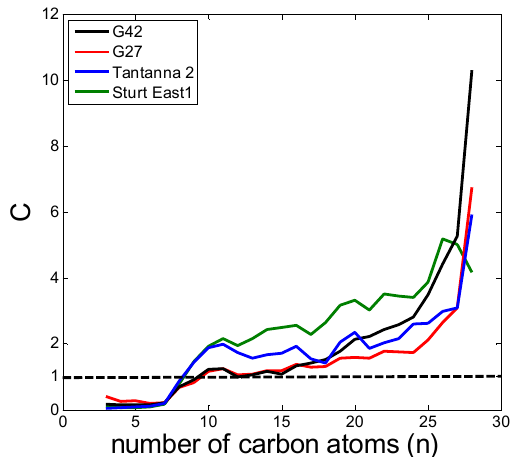
Figure 2. The ratio between concentration of hydrocarbons in source rock and in the reservoir in four wells.